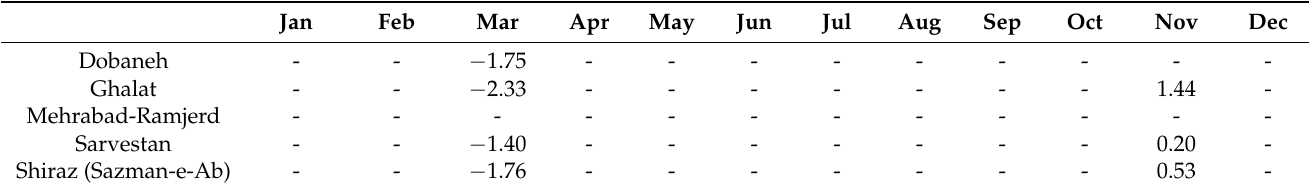
Table 7. Detected trend component in the monthly rainfall time series of selected stations.